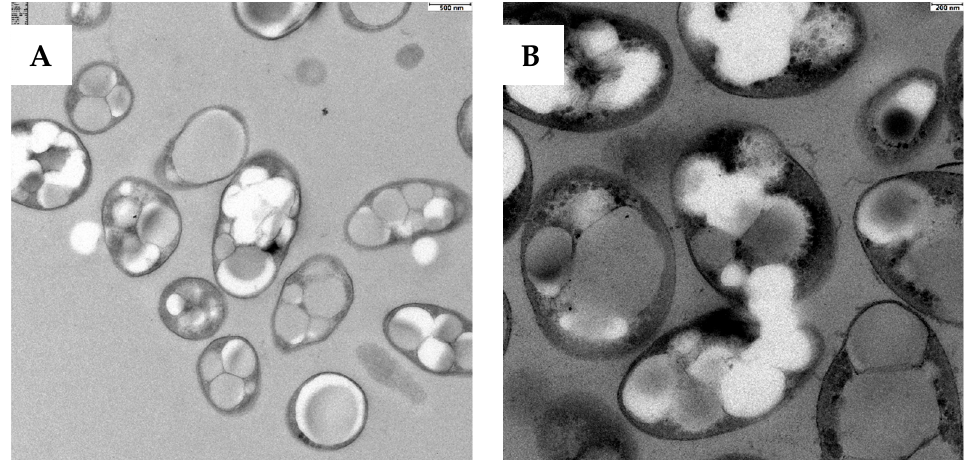
Figure 1. STEM micrographs of P. putida KT2440 cells. ( A ): untreated cells; ( B ) cells treated with 3.5 mM AgNO 3